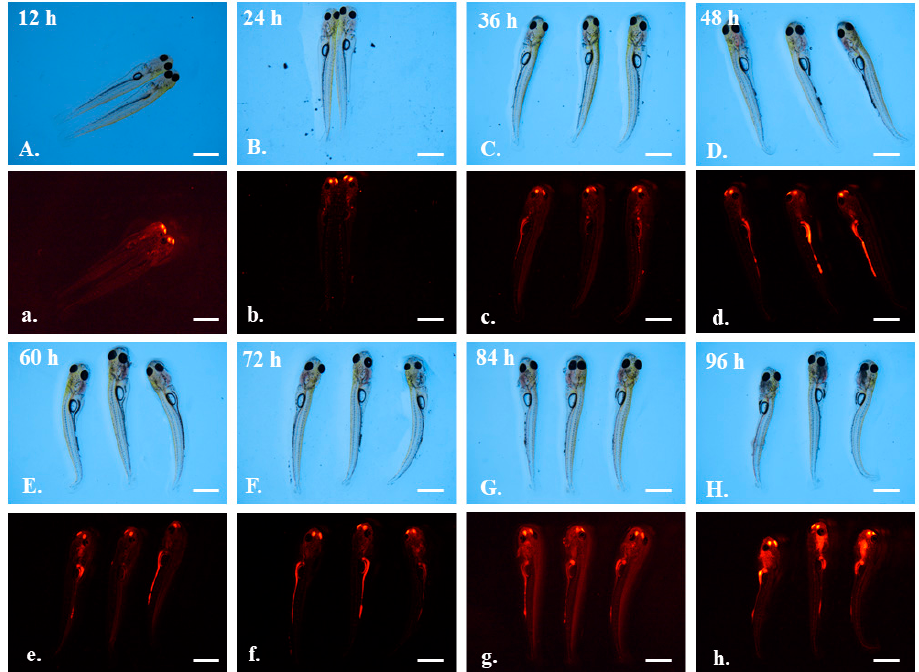
Figure 6. The larvae of grass carp after exposure to 1 μ m orange fluorescent microplastics. Photo- graphs were taken under a brightfield microscope (capital letters A – H ) and red fluorescent micro- scope (lowercase letters a – h ). Observation time was labeled in the figure. Scale bar = 2 mm.